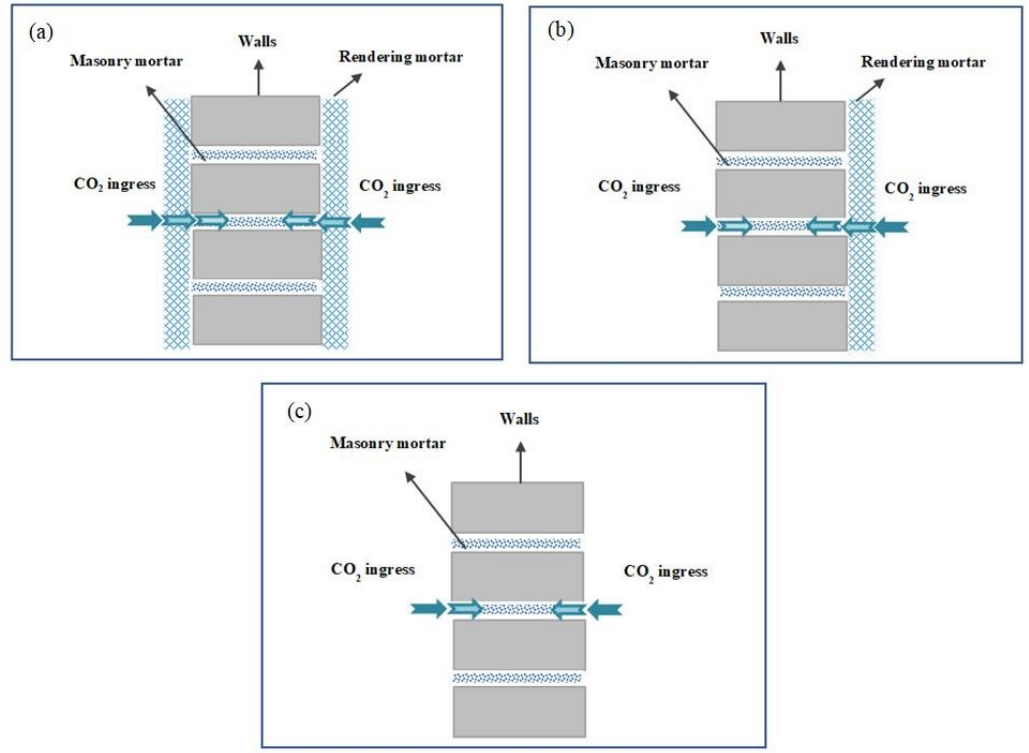
Figure 3. Two-dimensional schematic representations (cross-section) of the carbonation model for masonry mortar. (a) Masonry mortar with two-side rendering carbonation takes place by diffusion from both rendering layers before reaching the masonry; (b) masonry mortar with one-side rendering carbonation takes place by CO 2 diffusion from the rendering layer on one side and directly from the masonry on the other; (c) masonry mortar without rendering carbonation takes place by CO 2 diffusion directly from the exterior of the